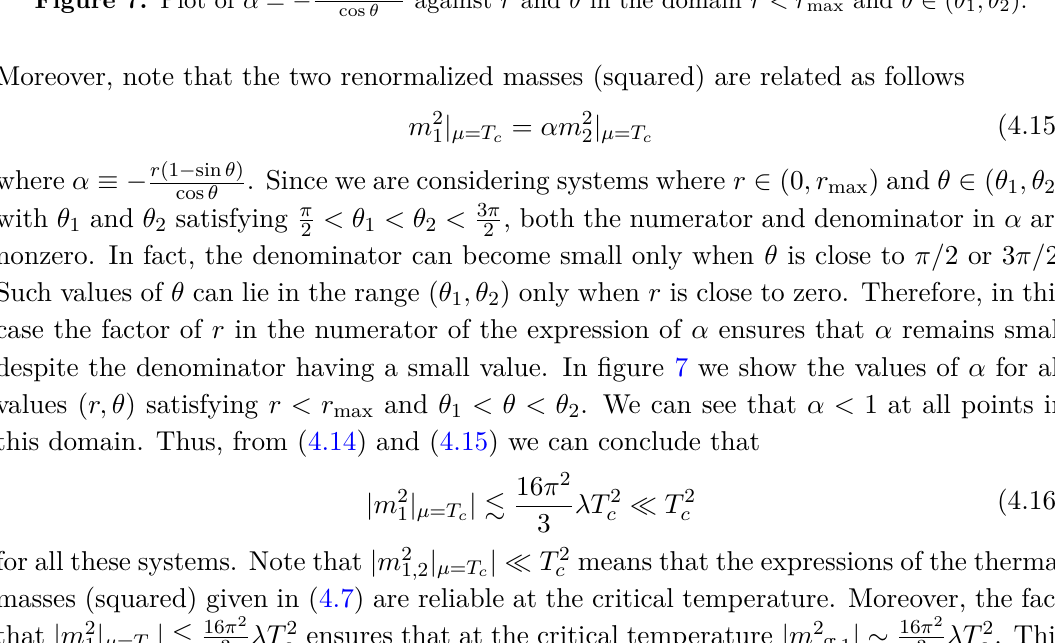
Figure 7. Plot of α = − r (1 − sin θ )